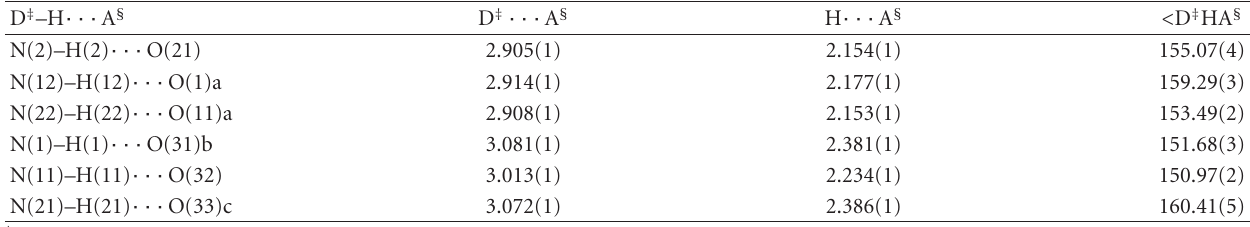
Table 7: Dimensions of the unique hydrogen bonds (distances in ˚A and angles in ◦ ) for complex 2 . †